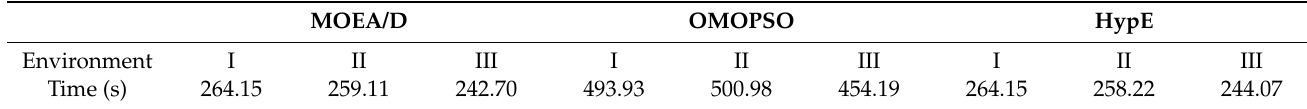
Table 2. Time taken by the three algorithms.